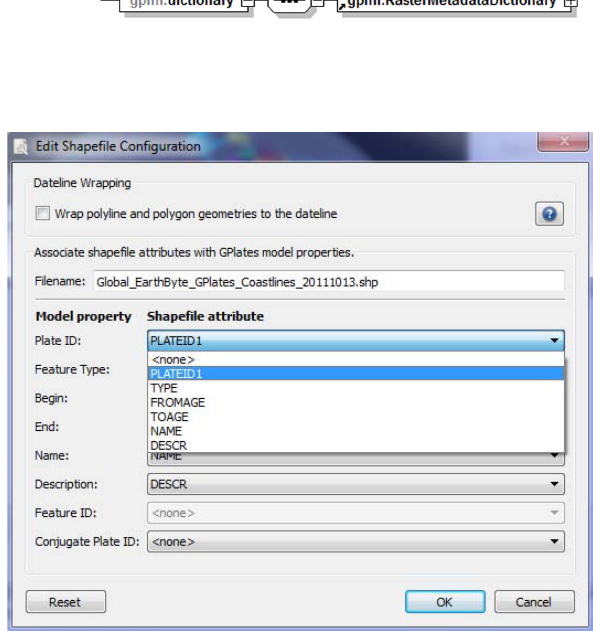
Fig. 30. The shapefile attribute mapping dialog of